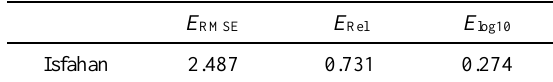
Table 1. The evaluation results of the DSM estimation E RMSE E Rel E log10 Isfahan